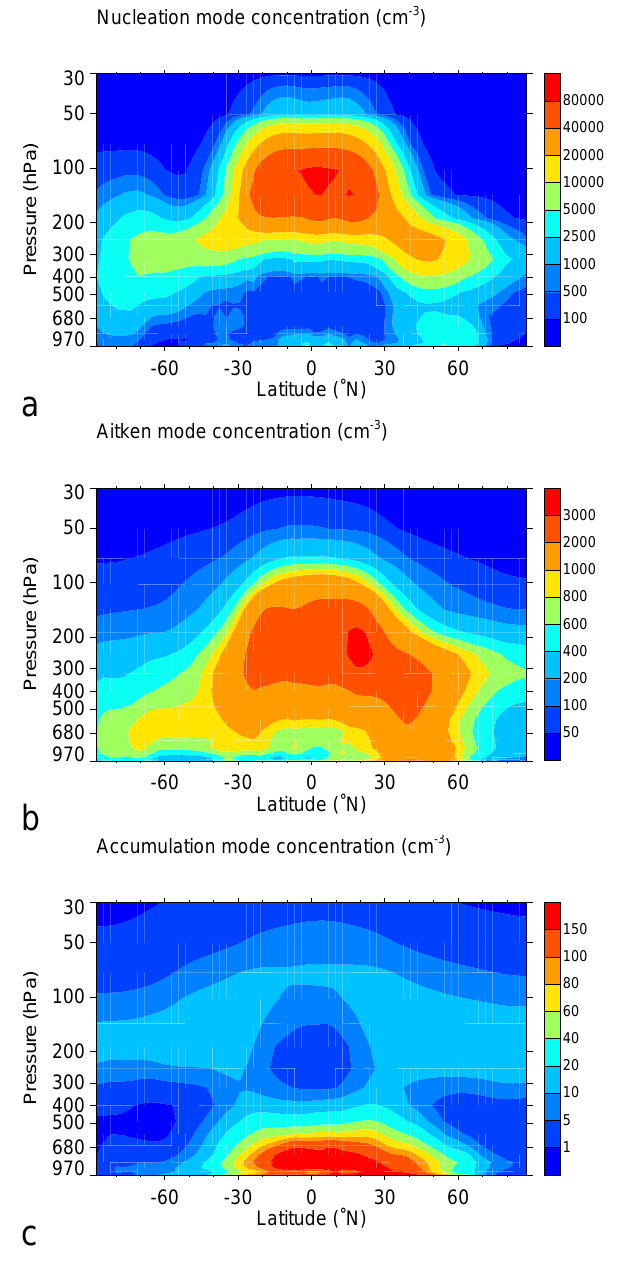
Fig. 8. Contribution of charged H 2 SO 4 /H 2 O nucleation in simulation S ref to the annual and zonal mean concentration of (a) nucleation, (b) Aitken, and (c) accumulation mode particles. The contribution to coarse mode particles (not shown) is very small.